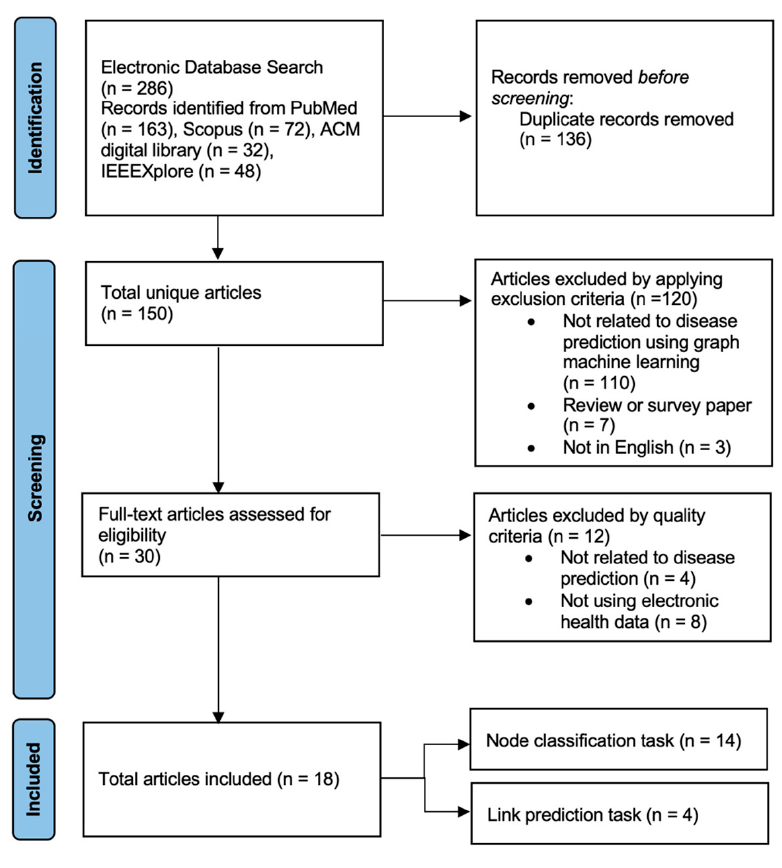
Figure 2. Article selection flowchart.